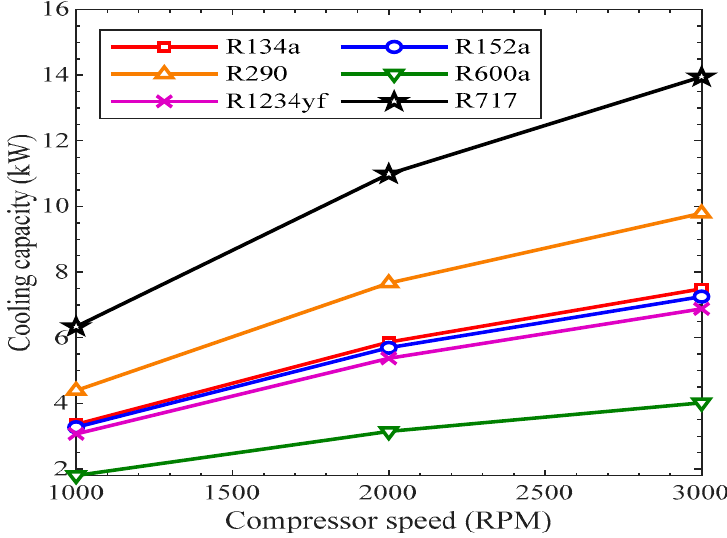
Figure 11. Cooling capacity vs. compressor speed for various refrigerants .